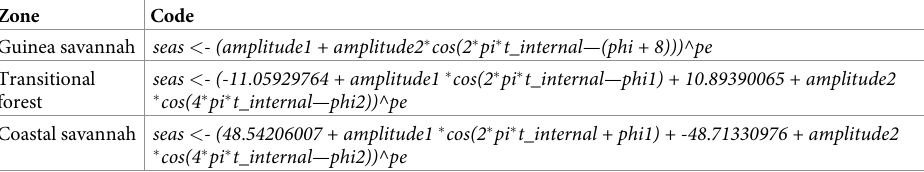
Table 1. Code for seasonality function applied to the three transmission settings across Ghana.